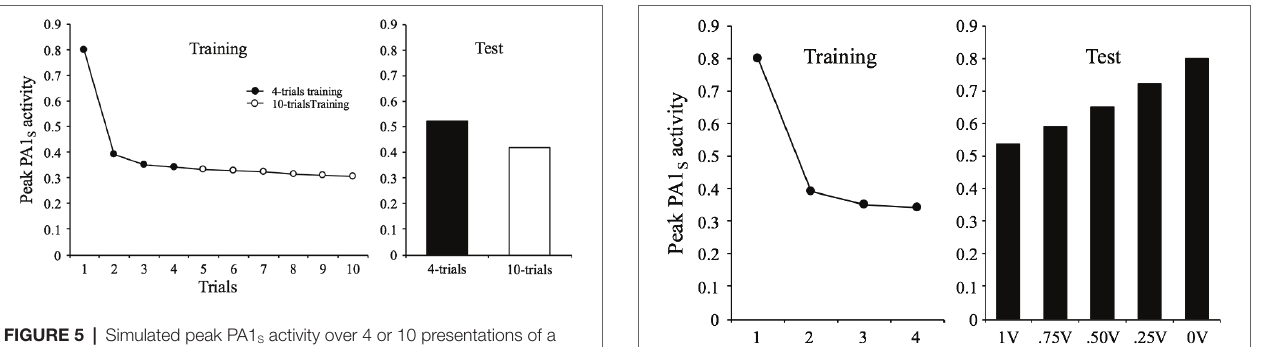
FIGURE 5 | Simulated peak PA1 S activity over 4 or 10 presentations of a 1-moment stimulus at a 32-moments inter-stimulus interval. The bar graph depicts the peak PA1 S activity in a single spontaneous recovery test-trial for the two training conditions.